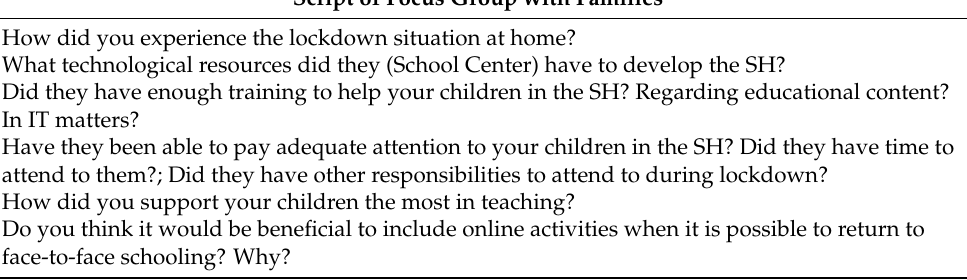
Table 3. Synthesis of questions that guided the development of the focus groups carried out with families.